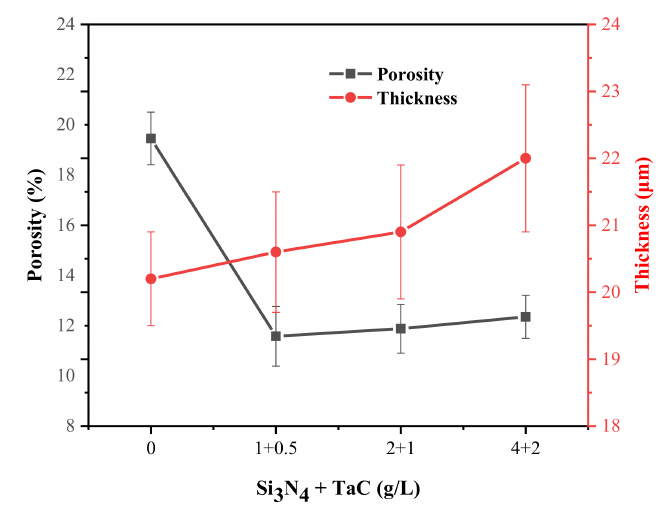
Figure 3. Surface porosity and thickness of the composite MAO coating with different concentration of Si 3 N 4 /TaC particles. Table 2. Surface characteristic of the MAO coatings with different concentration of Si 3 N 4 /TaC particles. Surface Density of Surface Density of Average Diameter of Specimen the Microholes, the Bright the Microholes, µ m Number/mm 2